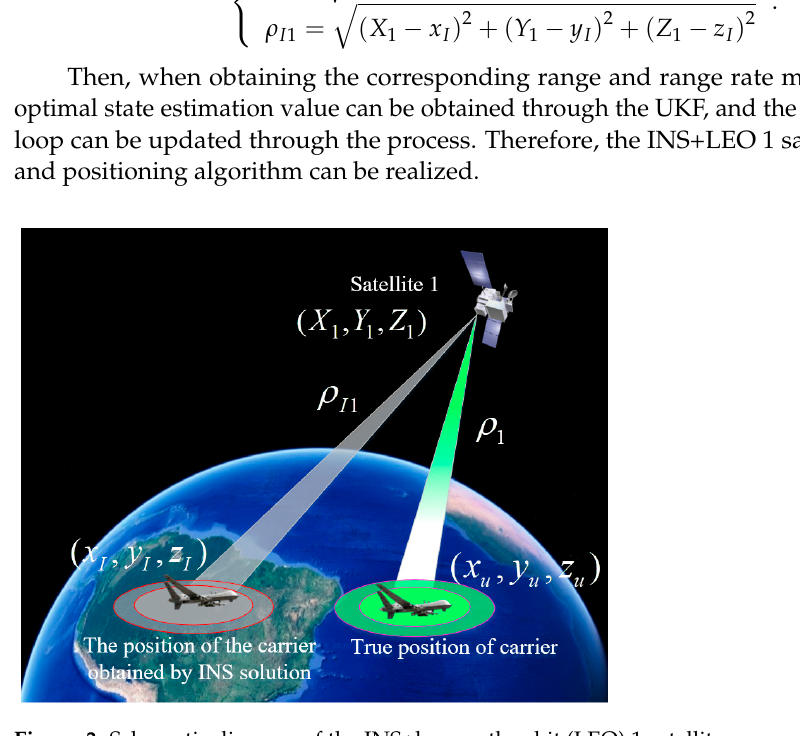
Figure 3. Schematic diagram of the INS+low earth orbit (LEO) 1 satellite compact integrated navi- gation algorithm without an altimeter.